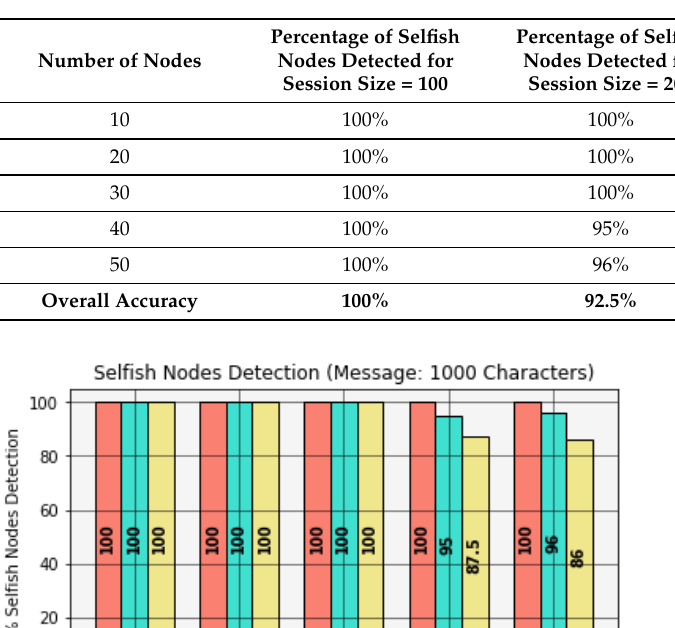
Table 9. Comparison between selfish node detection and number of nodes.